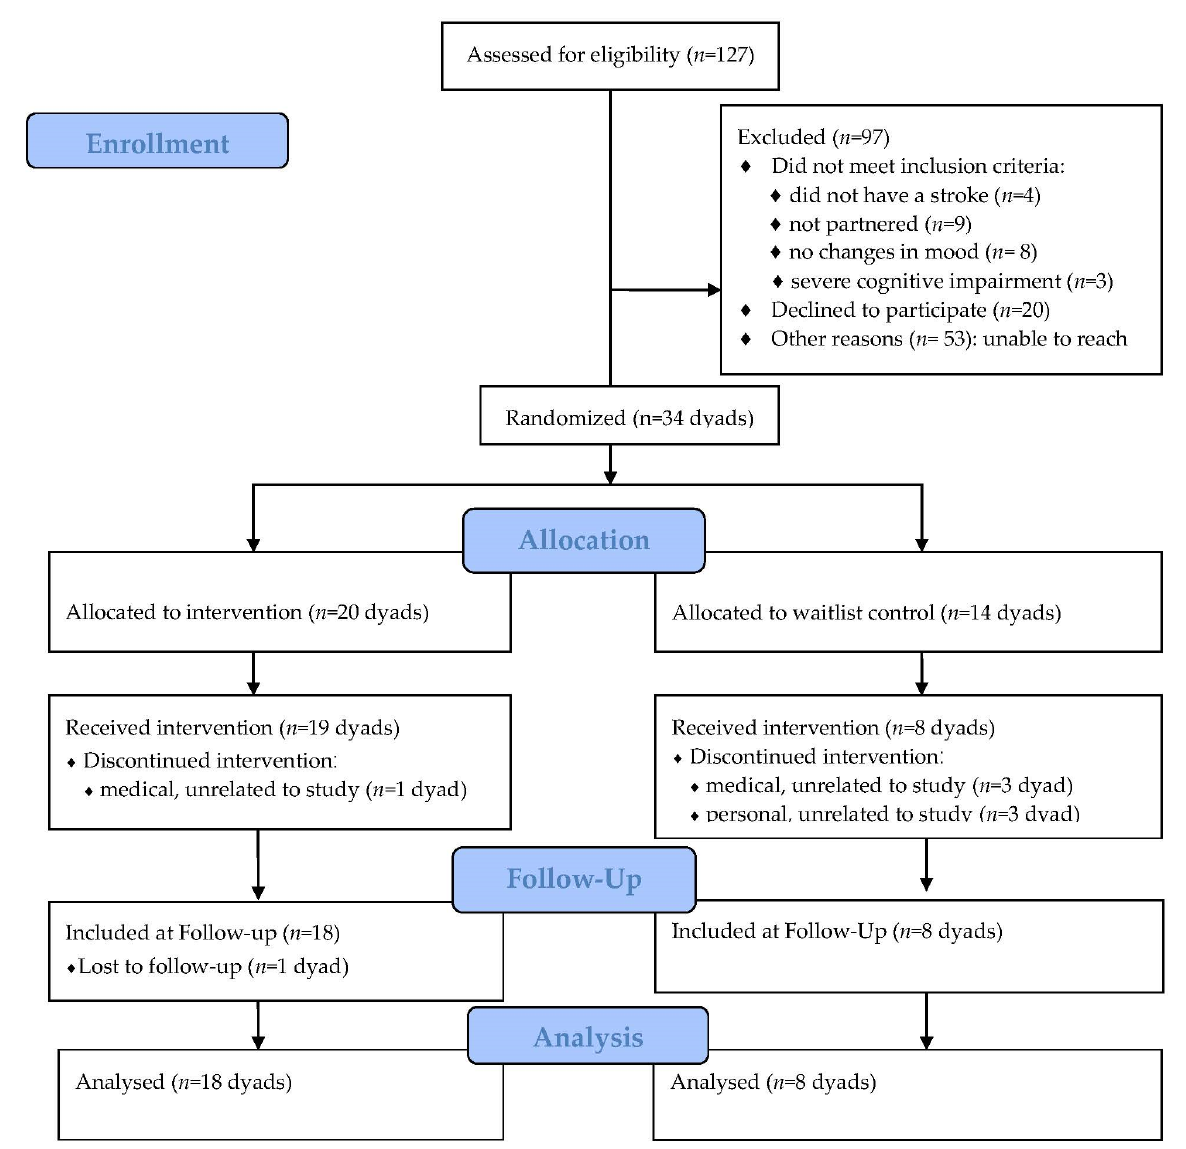
Figure 1. CONSORT diagram